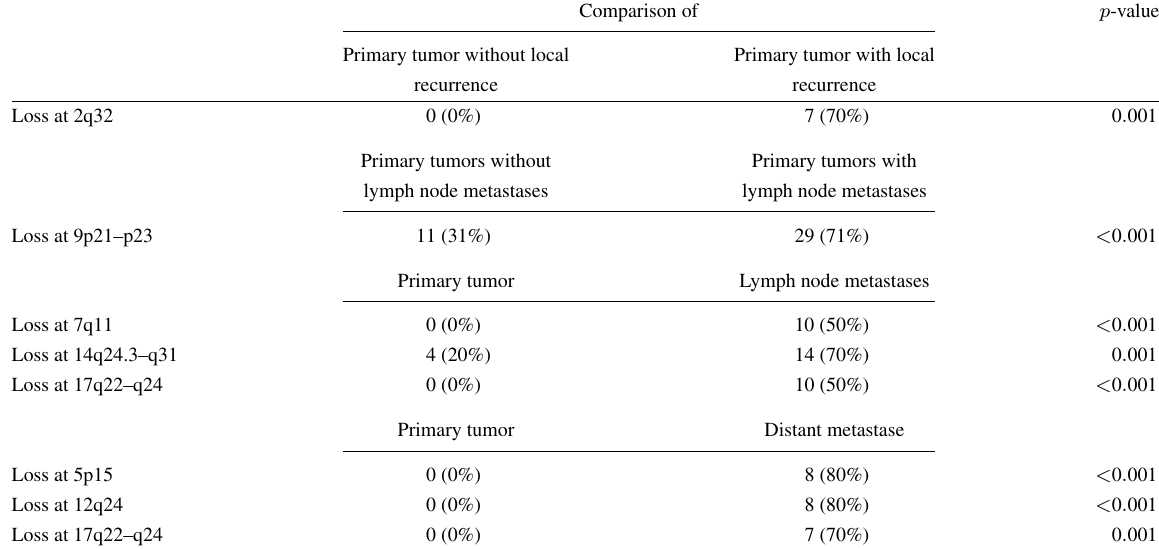
Results: Significant differences in recurrent chromosomal imbalances between the compared